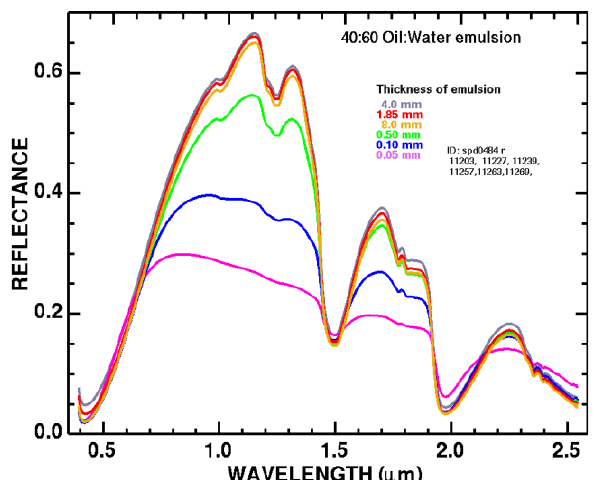
Figure 2: Reflectance spectra of 40:60, oil:water emulsion for a range of thicknesses (from Clark, 2010).